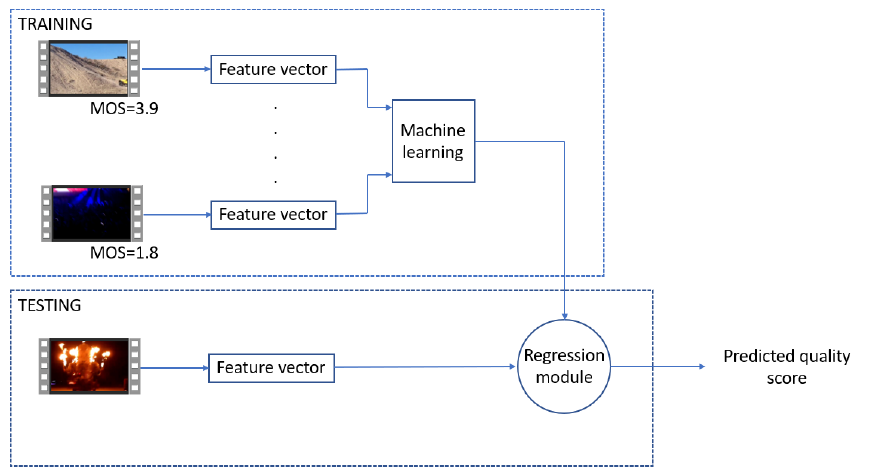
Figure 2. High-level overview of the proposed method. Video-level feature vectors are extracted from the training videos to train a machine-learning model, which is later utilized in the testing phase to predict the quality of previously unseen videos. In this study, we propose the fusion of the Benford-law-inspired first-digit distribution and perceptual